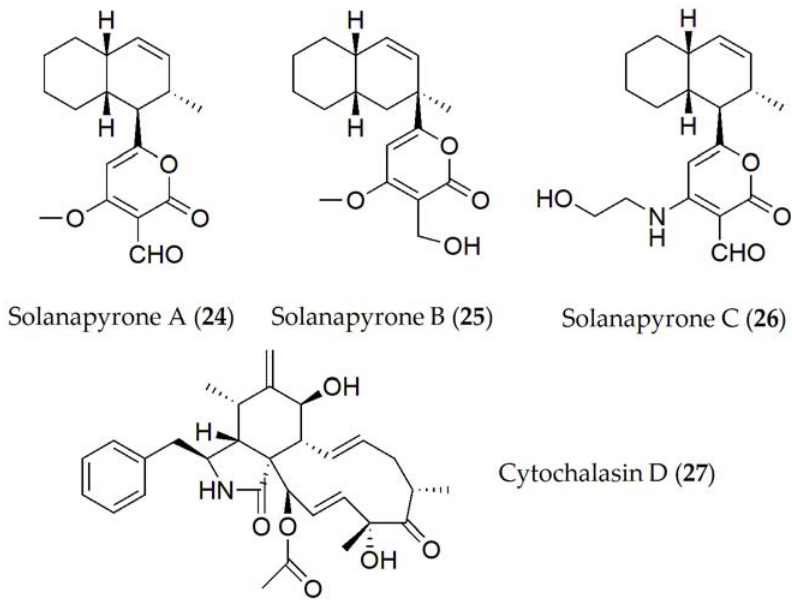
Figure 5. Phytotoxins isolated from Ascochyta rabiei . Structure–Toxicity Relationship Studies of Phytotoxins Produced by Ascochyta